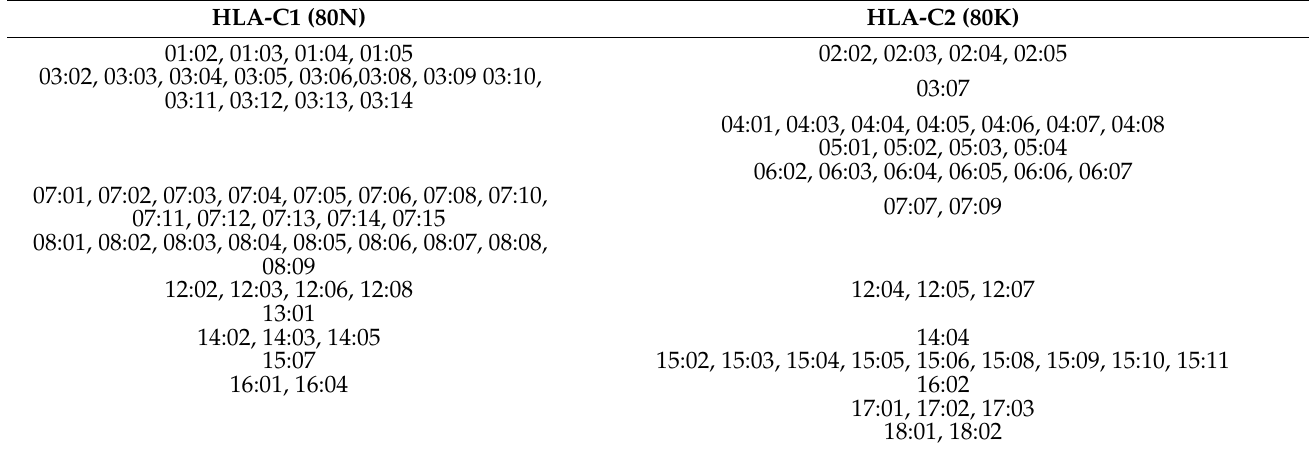
Table 1. Distribution of HLA-C1 and -C2